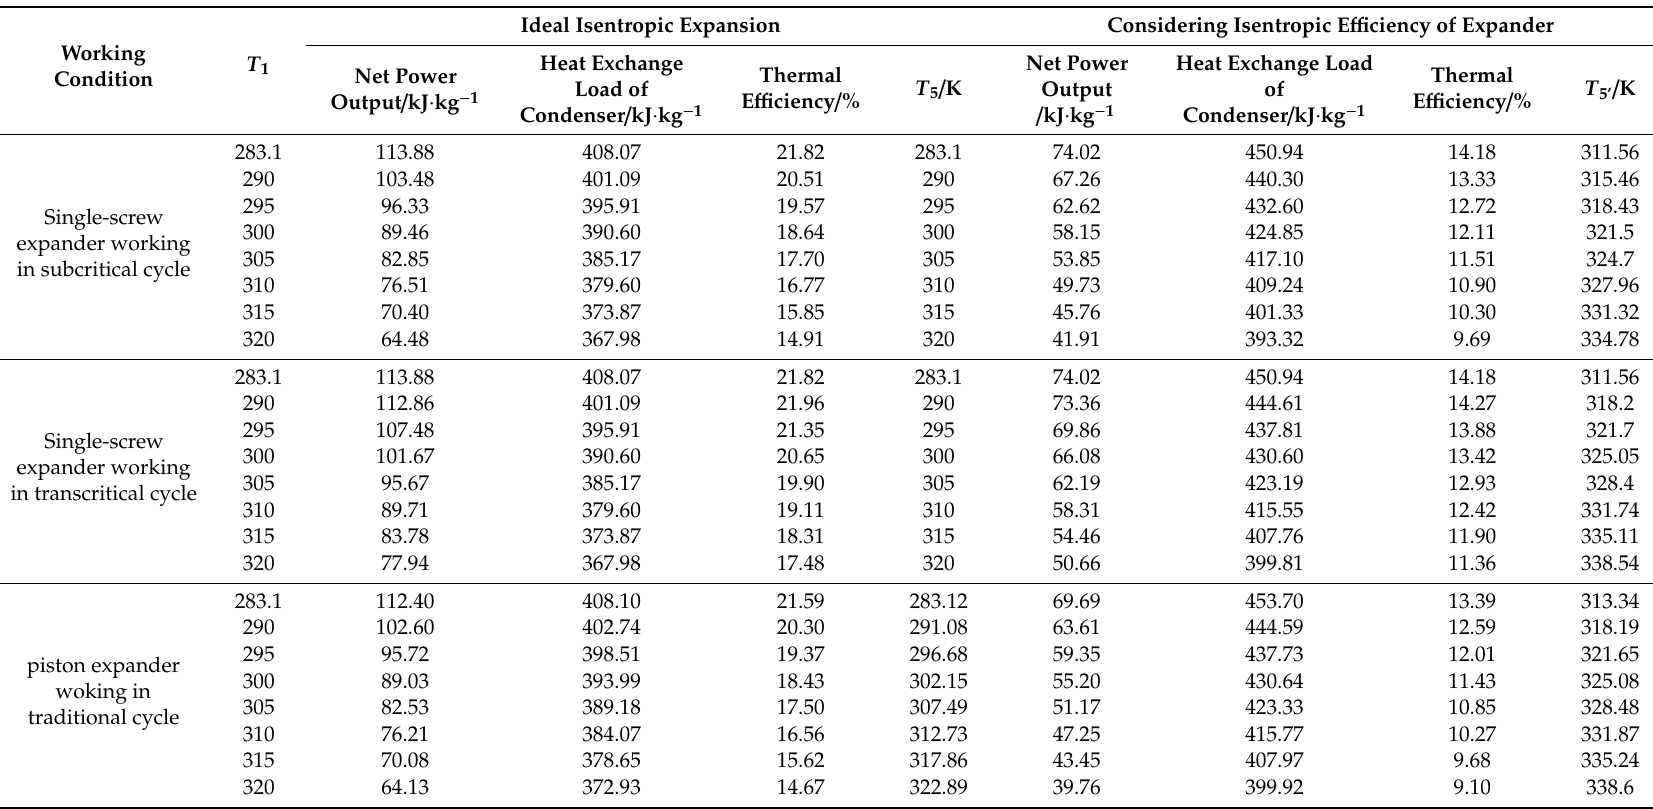
Table 6. Comparison of thermodynamic performance of cis-butene with and without consideration of the isentropic e ffi ciency of the